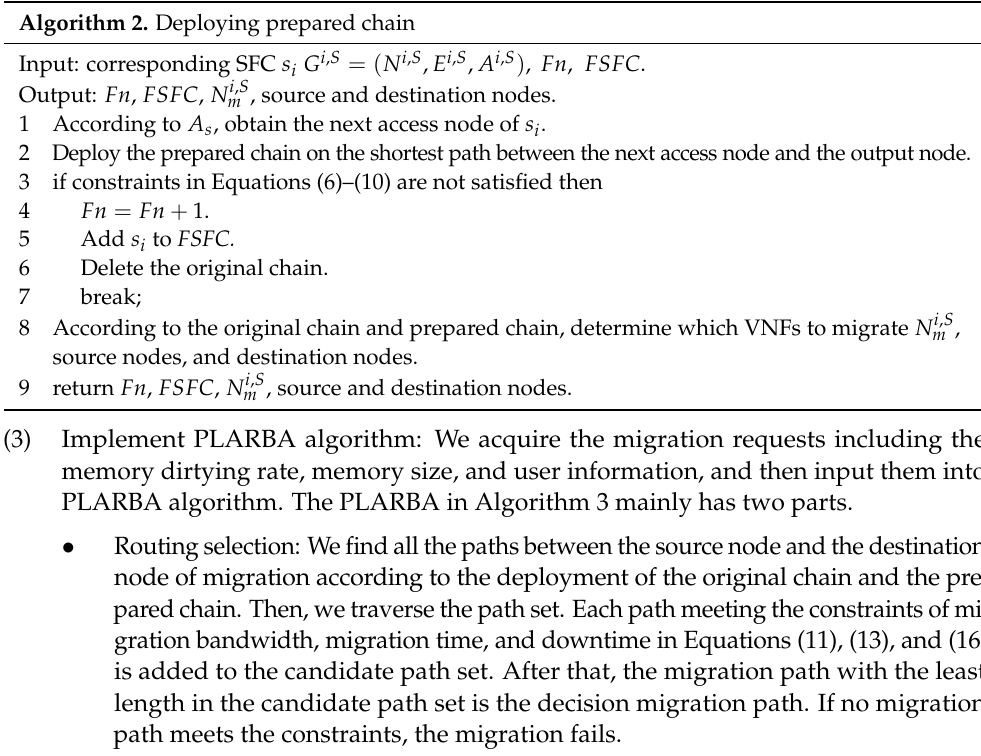
Algorithm 2. Deploying prepared